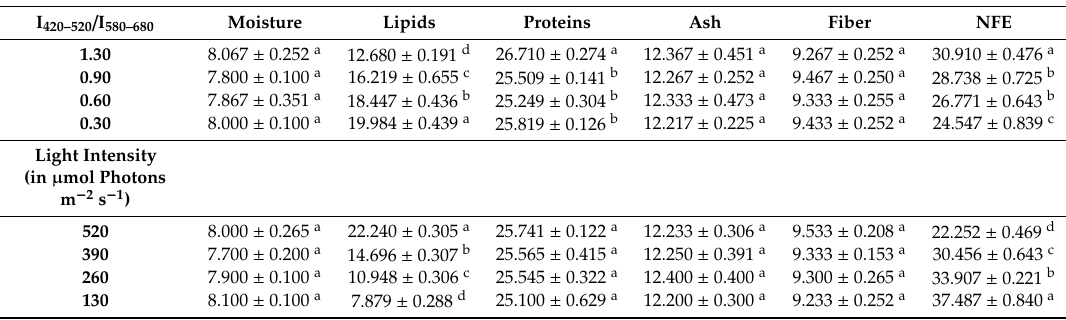
Table 4. Composition (%) of C. vulgaris cultivated at four di ff erent ratios (I 420–520 / I 580–680 ) and at four di ff erent light intensities with white and red LED lamps in the closed bioreactor (in µ mol photons m − 2 s − 1